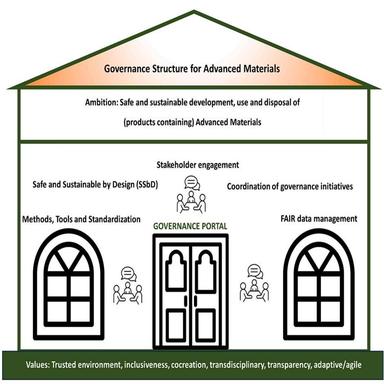
Schematic representation of a governance organisation structure for advanced materials.